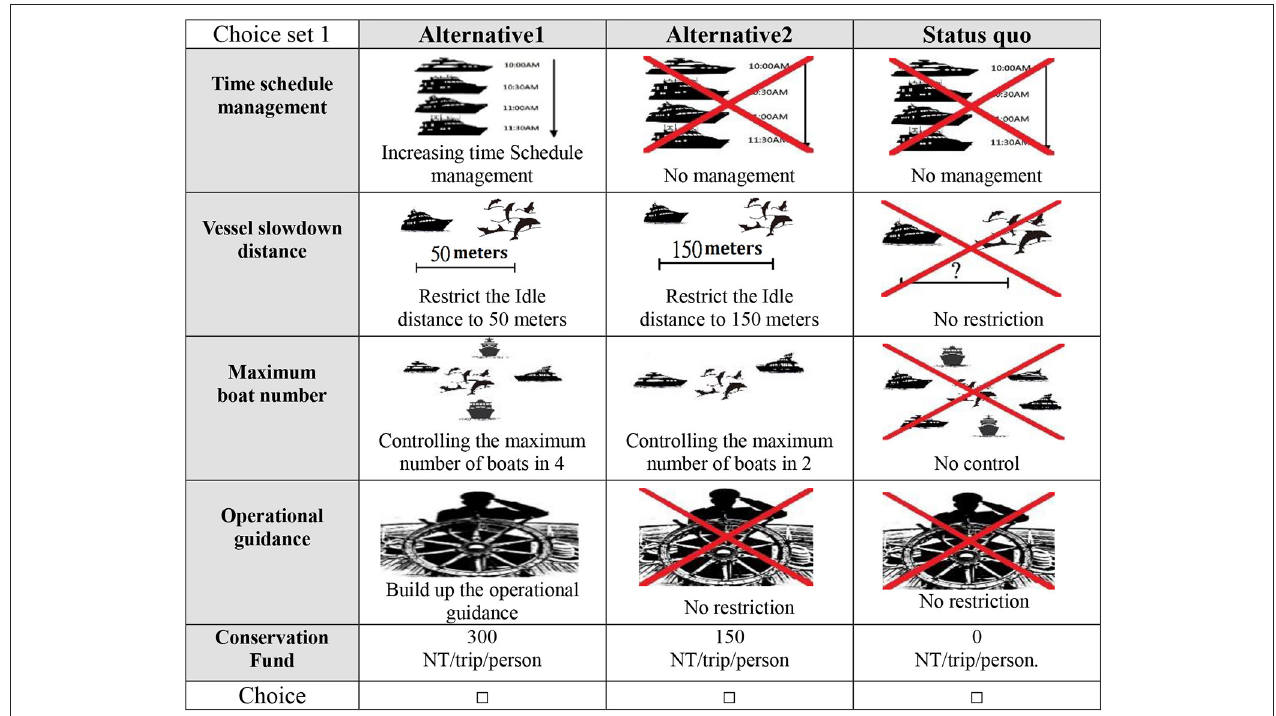
FIGURE 2 | An example of choice experiments question used in CE for foreign